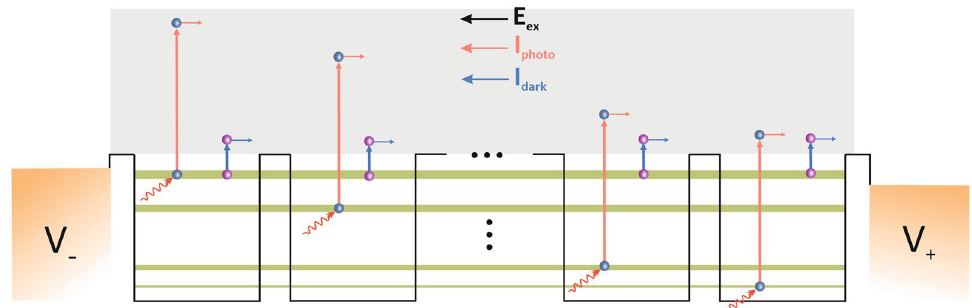
Figure 3. Mechanism of generating the output current through the intersubband absorption process. Flowing in the continuum band, E ex is labeled for external electrical field, dark current is labeled as I dark which is generating thermally and photo current is labeled as I photo which is generating